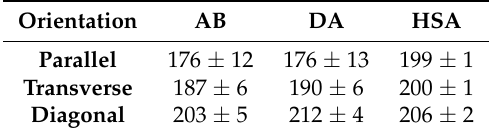
Table 3. Young’s modulus (GPa) in different orientations and post-treatments. Orientation